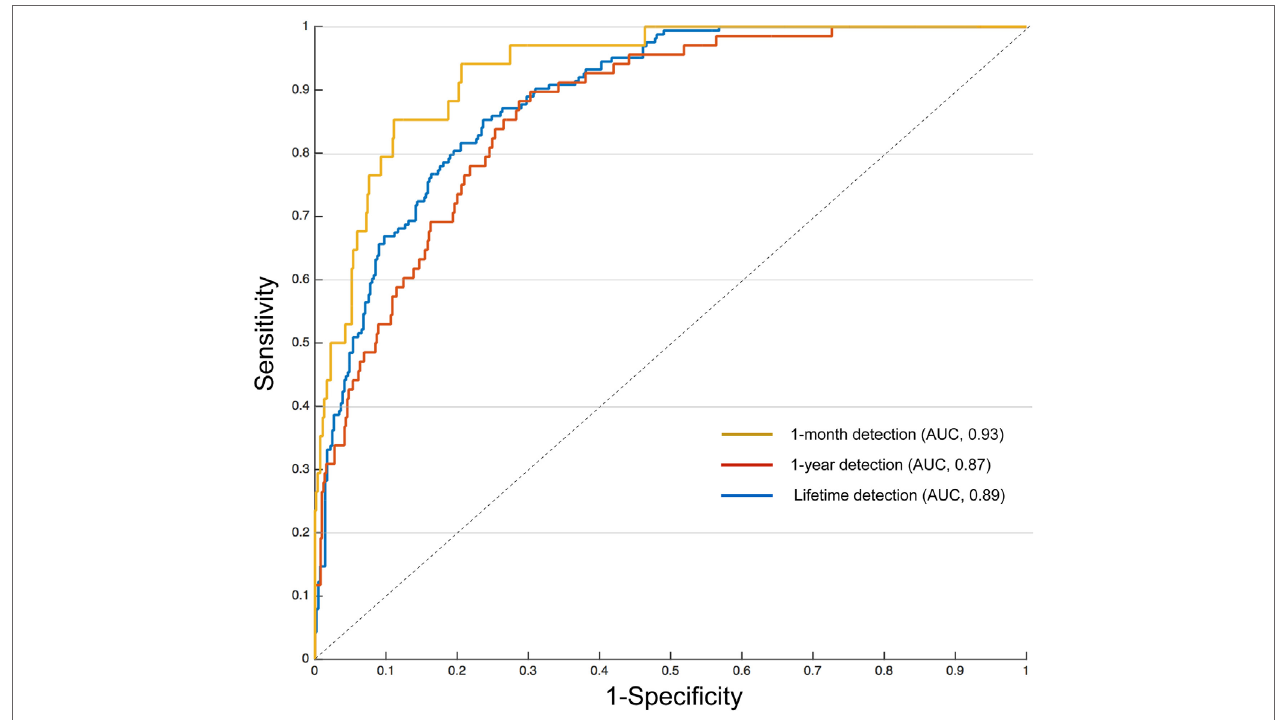
FigUre 1 | Receiver operating characteristics curves and area under the curve (AUC) for classifying suicide attempts with 41